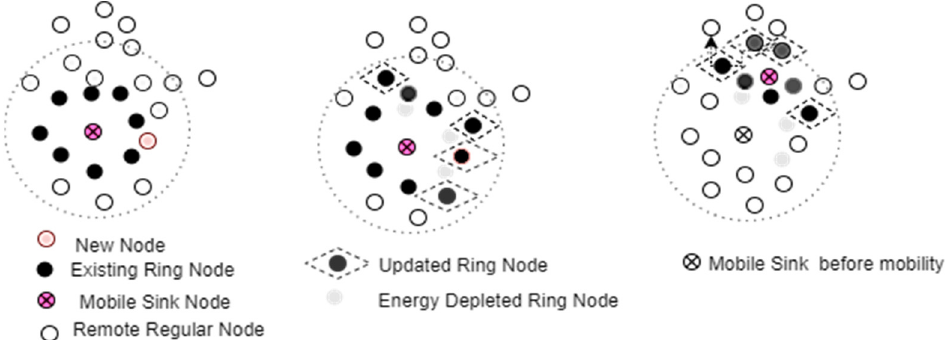
Figure 8. Data dissemination from the cluster head to the mobile sink node.